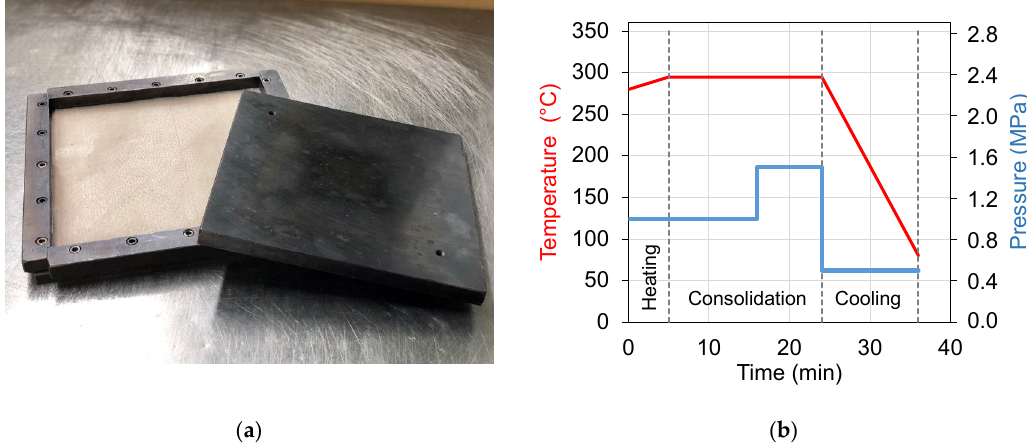
Figure 3. ( a ) Dipping edge tool and ( b ) cycle of thermal pressing for the hybrid laminates.